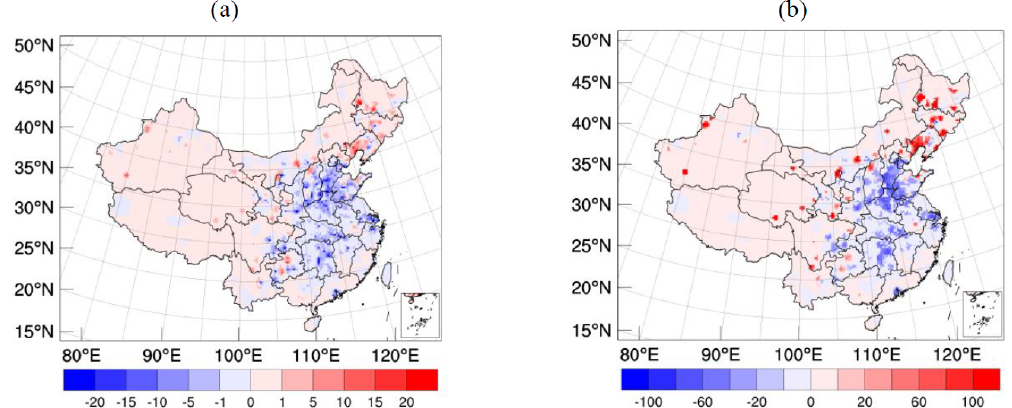
Figure 7. (a) Difference between 2020 and 2019 emissions, and (b) ratios of (2020–2019) / 2019 emissions in China. Units aremolkm − 2 h − 1 for (a) and percent (%) for (b) . Insets: South China Sea.